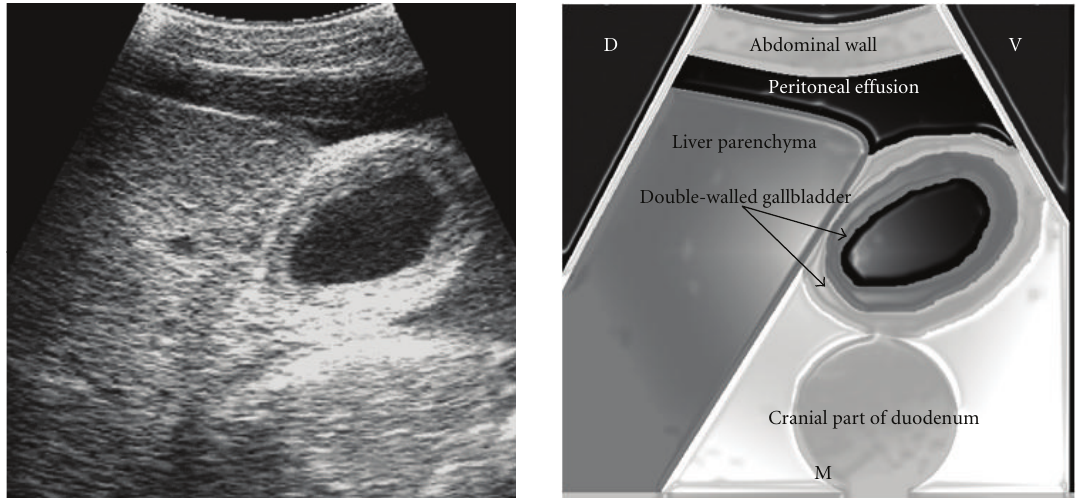
Figure 9: Ultrasonogram showing the edematous double-walled gallbladder, obtained from the 10th ICS. CVC: caudal vena cava; ICS: intercostal space; D: dorsal; V: ventral; M: medial.